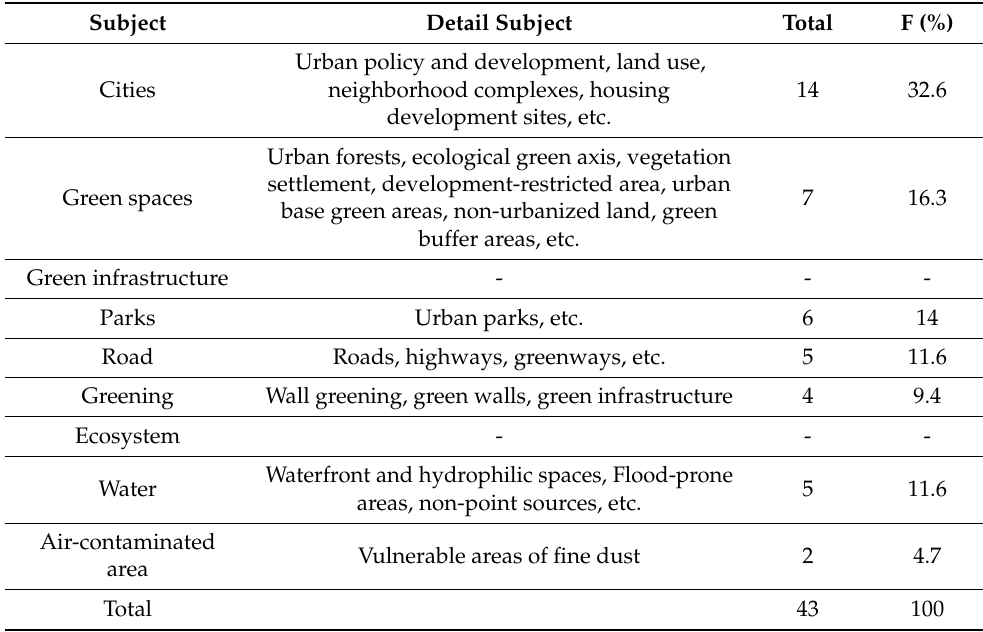
Table 5. Domestic green infrastructure research target in South